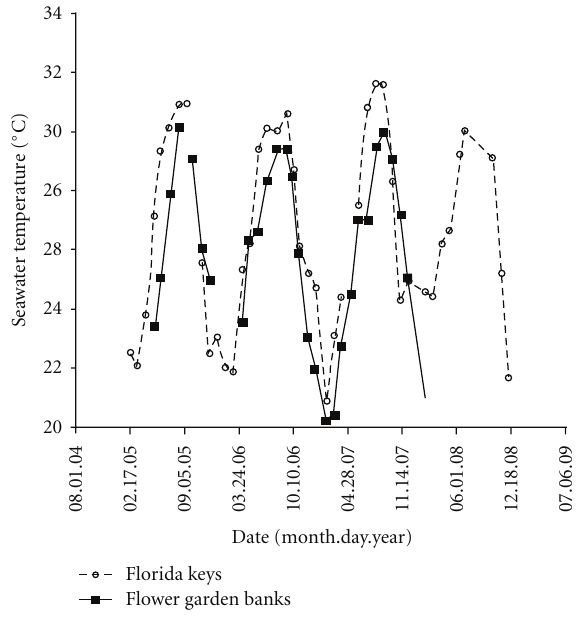
Figure 6: Temperature data spanning 2005–2008 from the West bank of the Flower Garden BanksNationalMarine Sanctuary (FGB- NMS) and the Florida Keys National Marine Sanctuary (FKNMS). All measurements were taken with submerged YSI devices. The FGBNMS and FKNMS data set gaps were due to YSI maintenance and hurricane